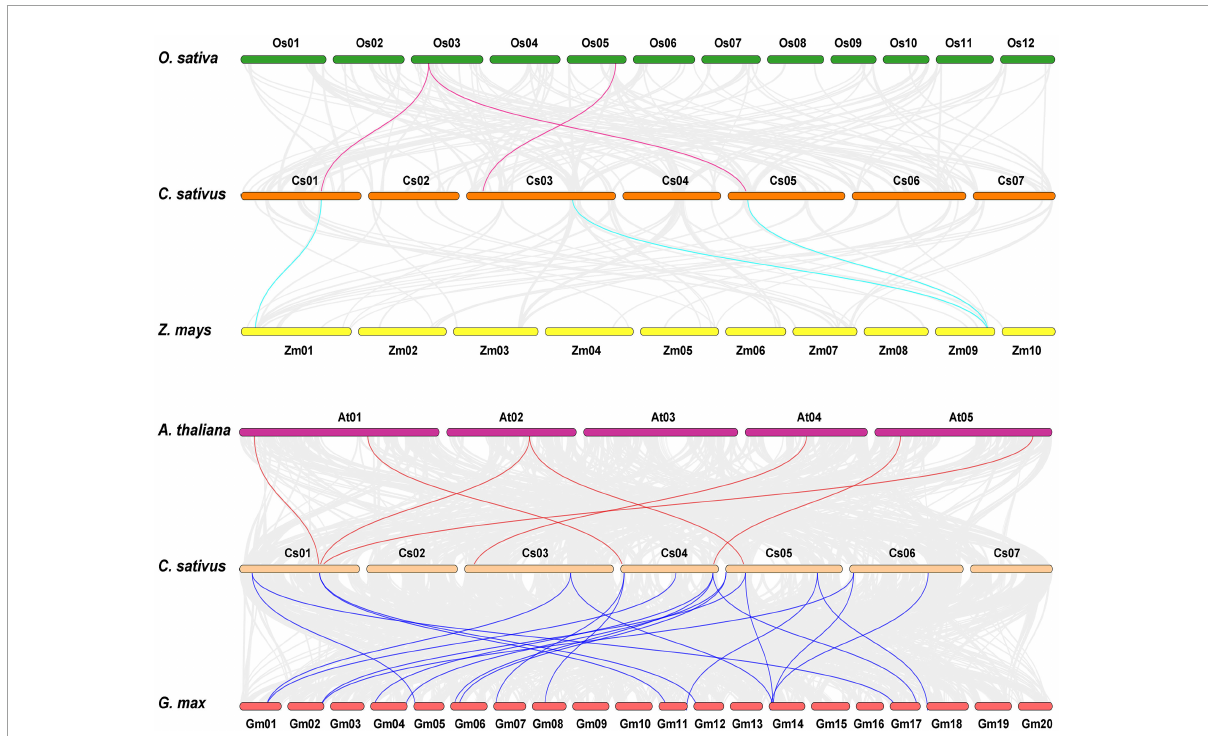
FIGURE2 Synteny analysis of HSP20 gene family between Cucumis sativus , Oryza sativa , Zea mays , Glycine max , and Arabidopsis thaliana . The gray lines indicated collinear blocks within cucumber genome and other plant genomes, while the colored lines showed the syntenic HSP20 gene pairs.